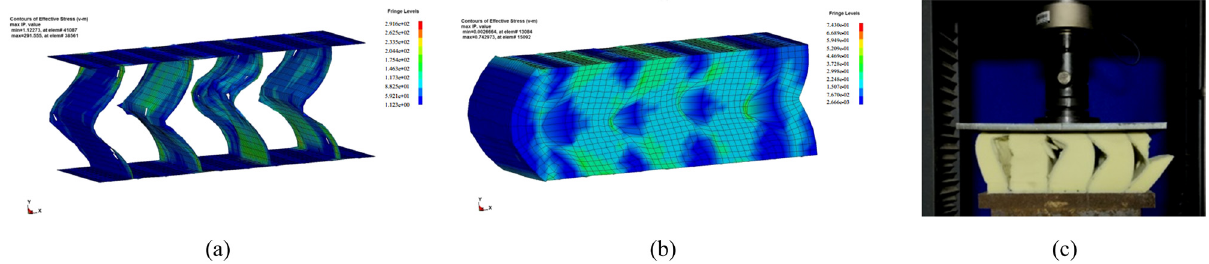
Figure 12: Strain and stress of specimen TS - V: ( a ) GFRP, ( b ) PU foam, ( c ) quasi - static experiment.